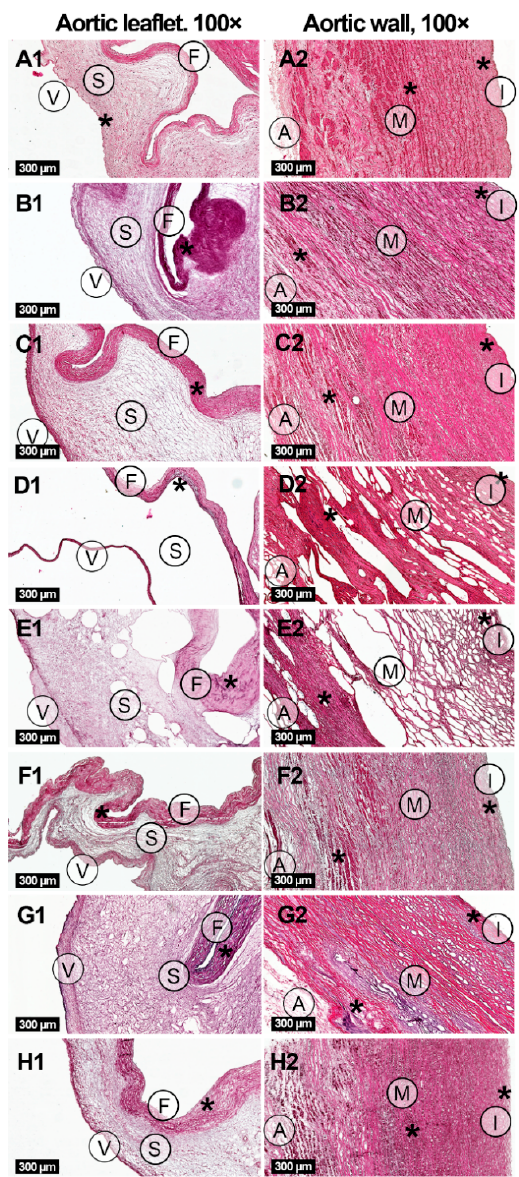
Figure 1. Histological study of native ( A1 , A2 ) and decellularized ovine aortic roots under hematoxylin-eosin staining. Decellularization protocols included scCO 2 -assisted processing at the pressure of 15 MPa ( B1, B2 ) and 25 MPa ( C1, C2 ) with the use of ethanol as a co-solvent; combinations of alkaline treatment with scCO 2 -assisted processing at the pressure of 10 MPa ( D1, D2 ) and 15 MPa ( E1, E2 ); detergents alone ( F1, F2 ) or with following scCO 2 treatment at the pressure of 15 MPa ( G1, G2 ) and 25 MPa ( H1, H2 ). Three layers are indicated in aortic valve leaflets: ventricularis (V), fibrosa (F) and spongiosa (S). Additionally, three layers are indicated in aortic walls: intima (I), media (M) and adventitia (A). Typical accumulations of cells are shown with asterisks (*, see Supplementary Figure S1 for enlarged images).